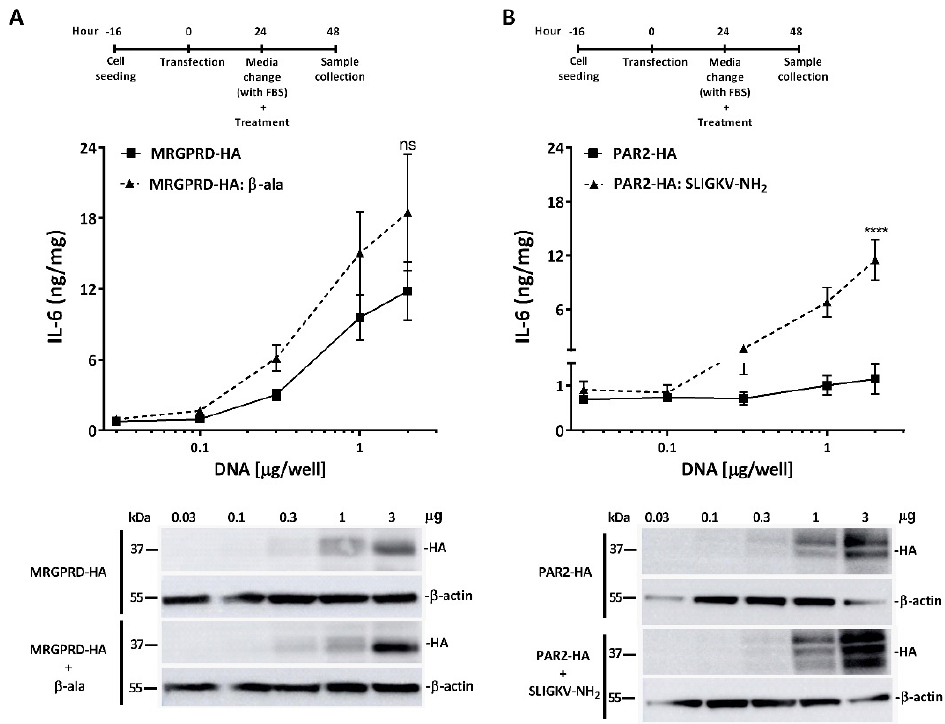
Figure 2. Basal activity of MRGPRD. HeLa cells expressing increasing concentrations of MRGPRD- HA and PAR2-HA receptors (transfected with 0.03, 0.1, 0.3, 1, and 2 µ g of cDNAs per well). When treated with vehicle control, the MRGPRD-transfected cells did show an MRGPRD expression- dependent release of IL-6 ( A ) , while the PAR2-transfected cells did not show PAR2 expression- dependent release of IL-6 ( B ). Furthermore, when cells expressing increasing concentrations of MRGPRD-HA or PAR2-HA were treated with their respective agonists, β -alanine (100 µ M) or the PAR2-agonist SLIGKV-NH 2 (100 µ M), a receptor concentration-dependent gradual IL-6 release was noticed ( A , B ). The release of IL-6 from vehicle-treated MRGPRD-HA cells points to basal activity of the receptor. Below the graphs, representative Western blot analysis of whole cell lysates from stimulated and non-stimulated HeLa cells transiently expressing increasing concentrations of MRGPRD-HA and PAR2-HA are shown. Each graph represents the mean ± s.e.m values from three independent experiments. The comparison between the two groups was analyzed by one- way ANOVA with Sidak’s post hoc test. **** p ≤ 0.0001 was considered significant and ‘ns’ is